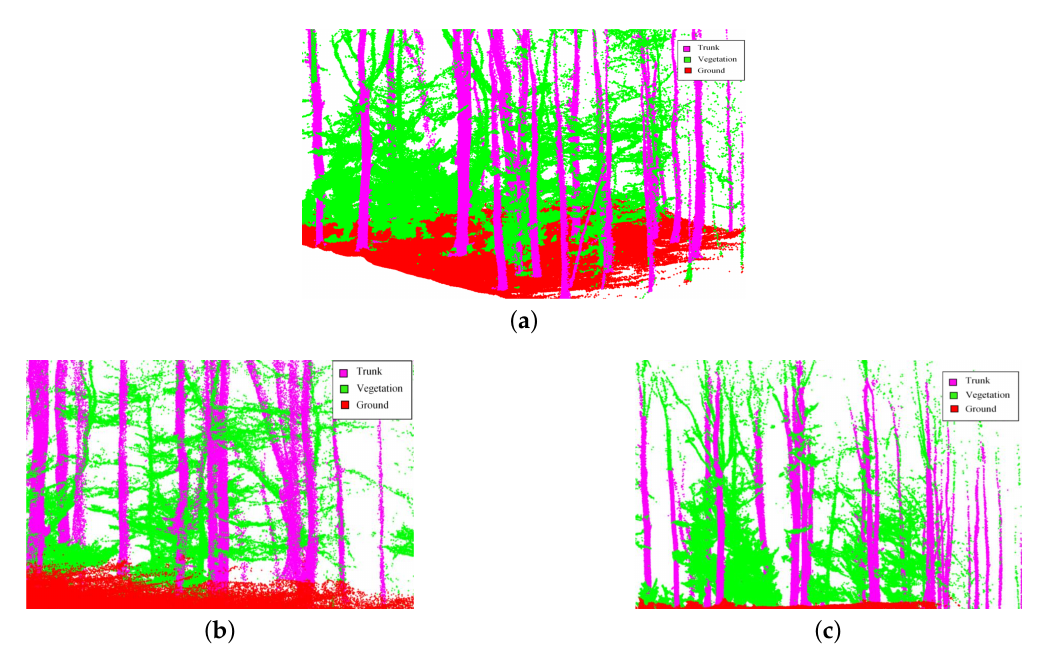
Figure 12. ( a – c ) present some segmentation and classification results for trees ( Quercus petraea ) from the Forêt de Tronçais in the Auvergne-Rhone-Alpes region (département de l’Allier) of Central France using a portable handheld scanning system (Data_set-2).